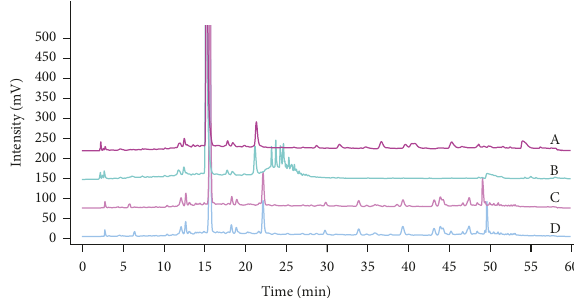
Figure 2: Effect of different concentrations of S7 sample on chromatogram (A for 8 mg/mL, B for 0.4 mg/mL).